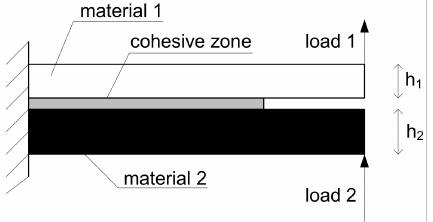
Figure 10. Double cantilever beam, data from